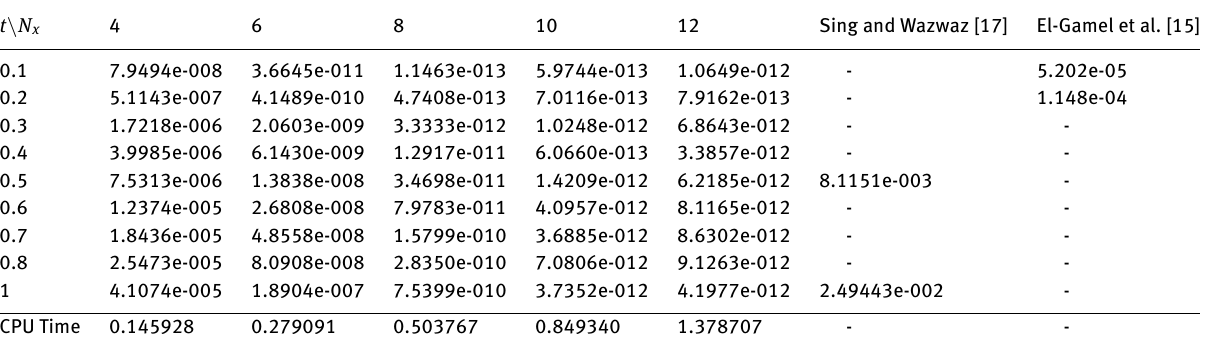
Table 3: Maximum errors E N for example 3 using N t = 10 and m = s =